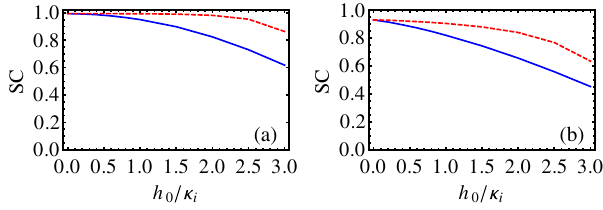
FIG. 4. Switching contrast as a function of the intrinsic cou- pling for (a) Stark control and (b) shuffle control. The time averages of transmissions T on and T off in Fig. 3 are used. T on is t ¼ 1 : 5 to 2 in (a) evaluated over the time period from (cid:4) i t ¼ 1 : 4 to 1.6 in (b), while T off is calculated and from (cid:4) i t ¼ 2 : 5 to 3 in (a) and from (cid:4) t ¼ 1 : 8 to 2 in (b). from (cid:4) i i The solid blue lines indicate the fixed external coupling ffiffiffiffiffiffiffiffiffiffiffiffiffiffiffiffiffiffiffiffi q h 2 max þ (cid:4) 2 (cid:4) ex ¼ , while the dashed red lines present the optimal i q ffiffiffiffiffiffiffiffiffiffiffiffiffiffiffiffiffiffiffiffiffiffiffiffiffiffiffiffiffiffiffiffiffiffiffi ð h max (cid:3) h 0 Þ 2 þ (cid:4) 2 and (cid:2) in ¼ h max (cid:3) h 0 critical coupling (cid:4) ex ¼ i